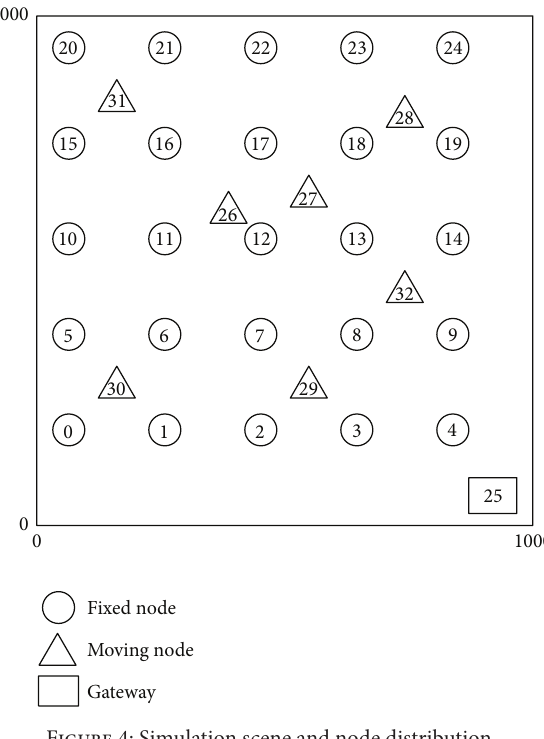
Figure 4: Simulation scene and node distribution. Table 1: Parameter setting for simulation environment.